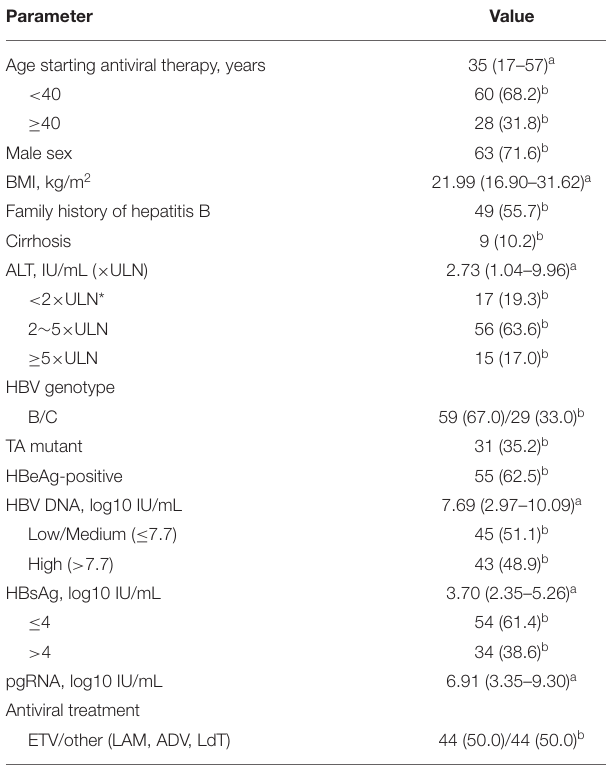
TABLE 1 | Baseline parameters of all 88